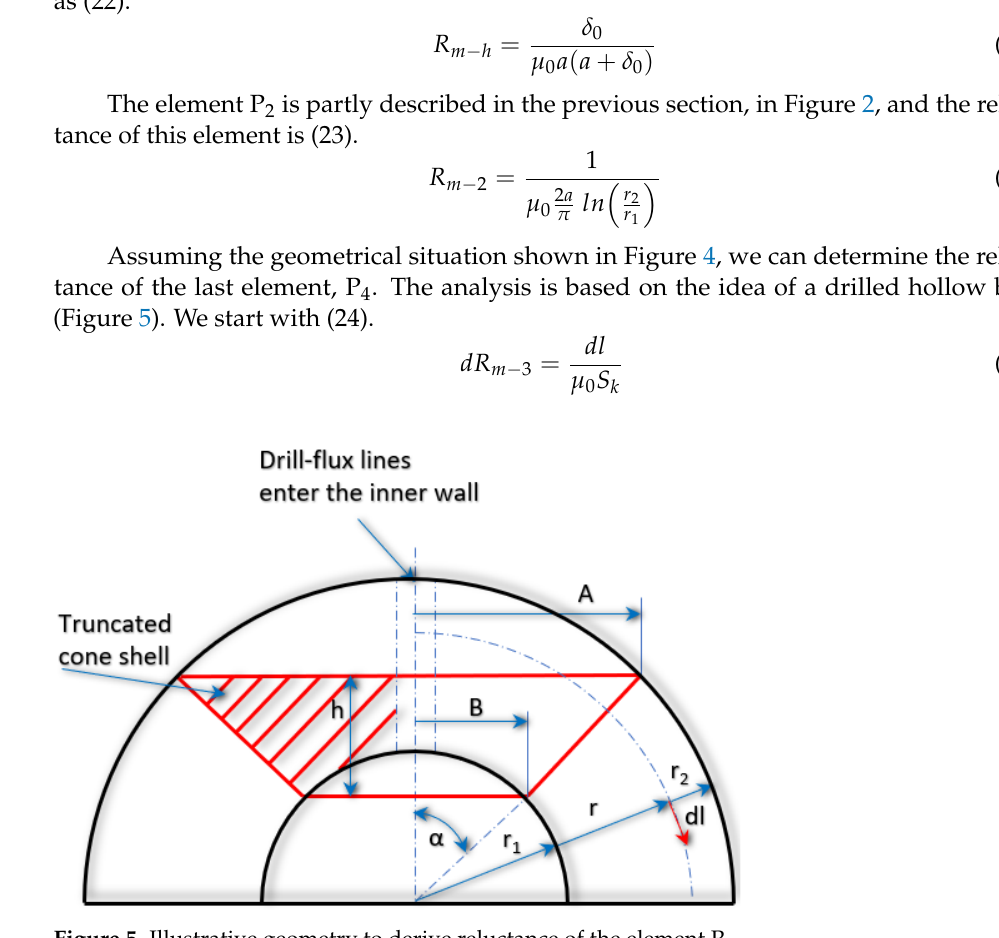
Figure 5. Illustrative geometry to derive reluctance of the element P 4 .